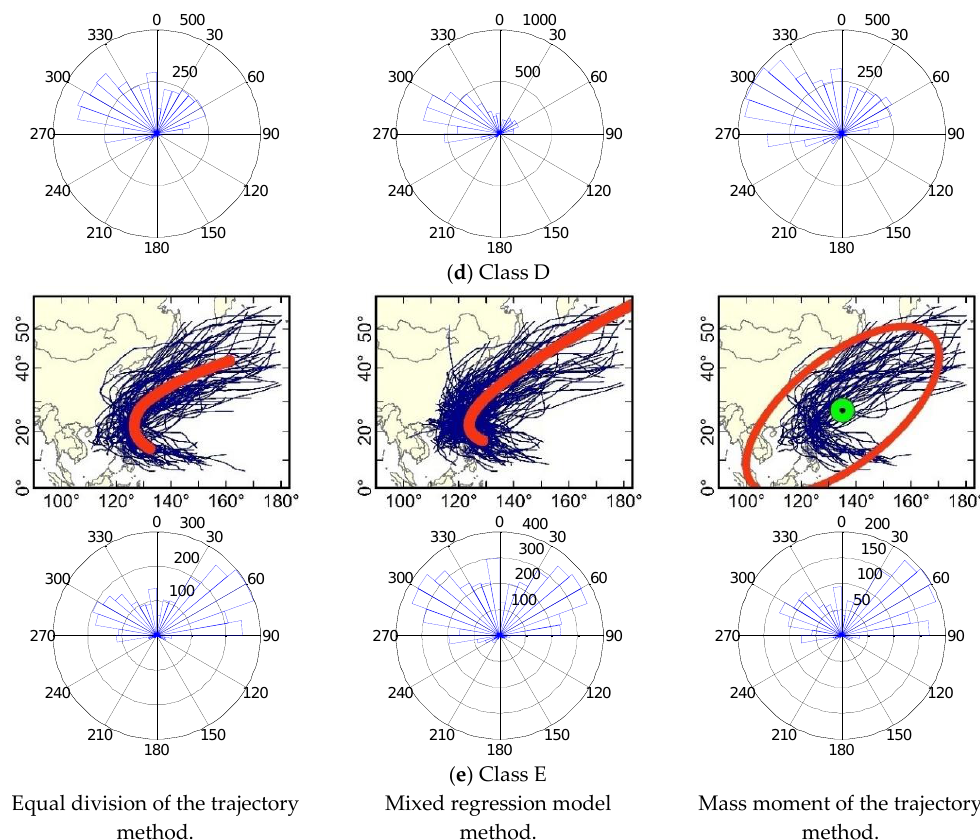
Figure 3. ( a – e ) TC trajectory clustering results and corresponding heading frequency distribution of TC movement obtained by the different trajectory clustering methods.